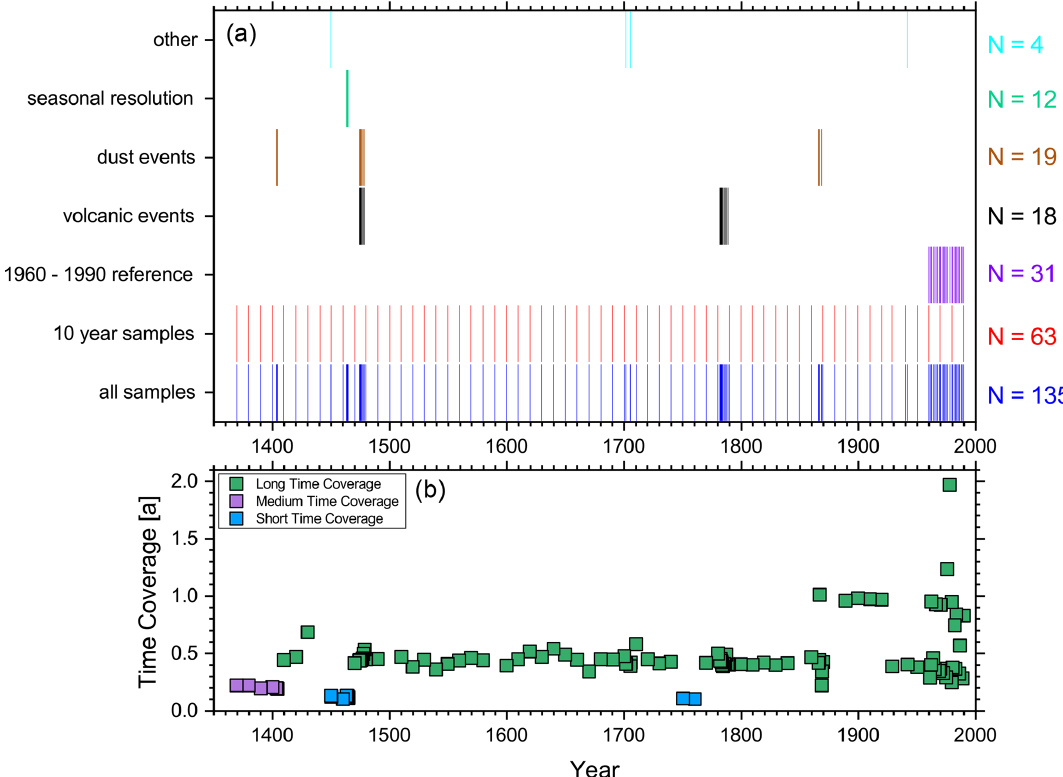
Figure 1. (a) Temporal distribution and number of ice nucleation samples for different groups (colors). (b) Time coverage of the samples selected for assessing IN properties. The different colors represent a broad grouping into samples averaging over short, medium, and long time